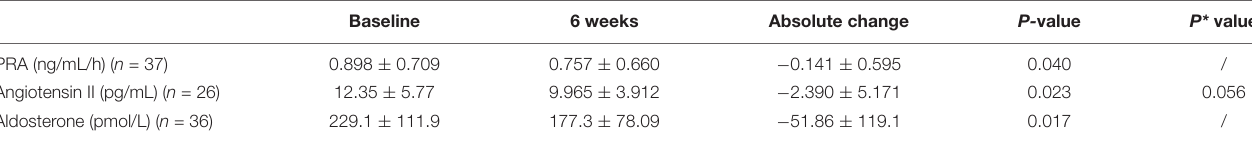
TABLE 4 | Effect of bisoprolol on plasma renin activity (PRA), angiotensin II and aldosterone after 6 weeks’